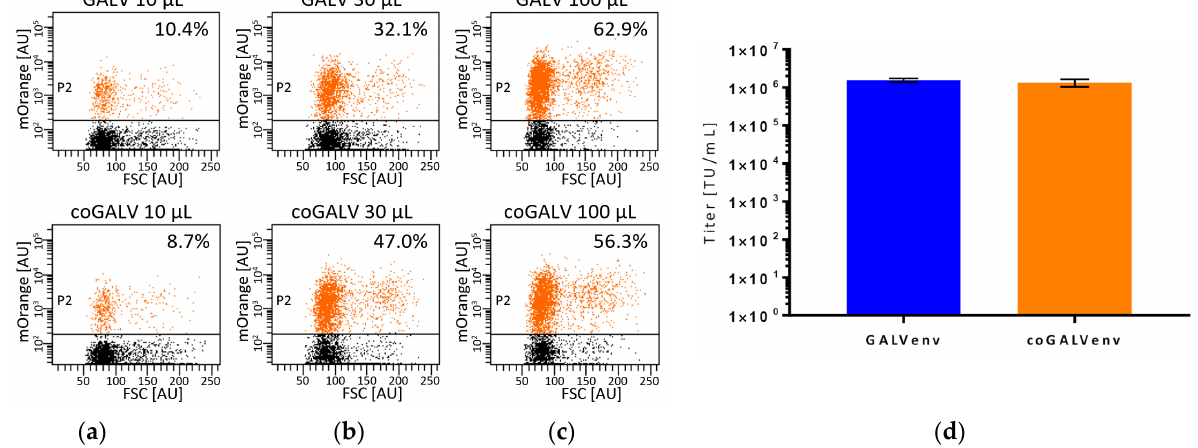
Figure 2. Titers of lentiviral LeGO-mOrange2 vectors produced in standard-scale with GALV-env and coGALV-env. GALV-env-vectors were produced in triplicates with 640 ng of plasmid/10 6 cells, coGALVenv-vectors with 20 ng of plasmid/10 6 cells. ( a – c ) Exemplary dotplots of transduced primary human T cells for three different amounts (10, 30, 100 µL) of vector-containing supernatant produced with GALV-env or coGALV-env. Clear-cut separation of transduced vs. non-transduced cells even in demanding cells facilitates unequivocal determination of transduction rates indicated; ( d ) Means and standard deviations of titer determination performed in triplicates. No significant difference in titers as measured on 293T cells was seen by t-test. FSC = forward scatter, AU = arbitrary units of area signal.